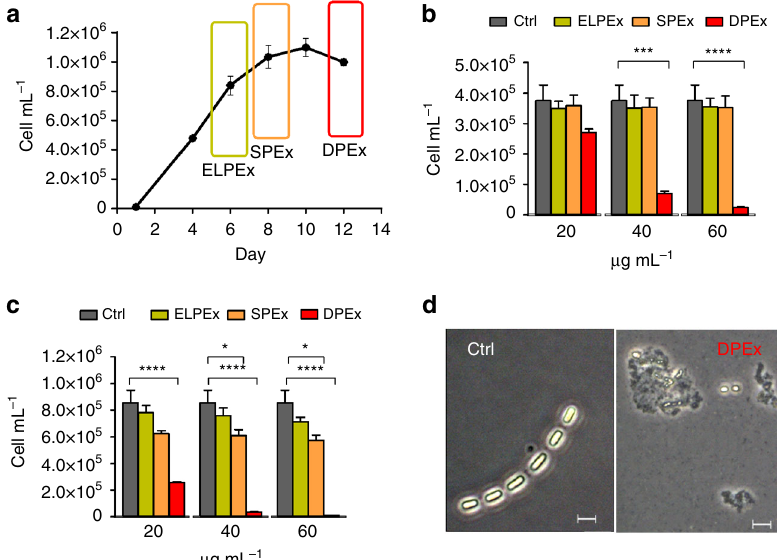
Fig. 1 Autoinhibitory activity of S. marinoi extracts on diatom growth. a Growth curve of S. marinoi . The rectangular sections indicate the time when cells were harvested and extracted. b , c Response of healthy S. marinoi cells (3 × 10 5 cells) after 24 h ( b ) and 48 h ( c ) exposure to growth phase-derived extracts in MeOH (20, 40, and 60 µ g mL − 1 ). Activity is expressed as cell concentrations (cell mL − 1 ) compared to samples treated only with vehicle (Ctrl). Data are means ± s.d. of triplicates of four independent experiments. ELPEx = end of the log phase extract; SPEx = stationary phase extract; DPEx = declining phase extract; Ctrl = control (MeOH); * P < 0.01; *** P < 0.001; **** P < 0.0001 (two-way ANOVA); d Formation of cell aggregates in S. marinoi cultures after 48 h exposure to 20 µ g mL − 1 of extracts from cells harvested in the declining growth phase (DPEx). Ctrl = untreated cells. Images were taken at ×400 magni fi cation. Scale bars depict 5 μ